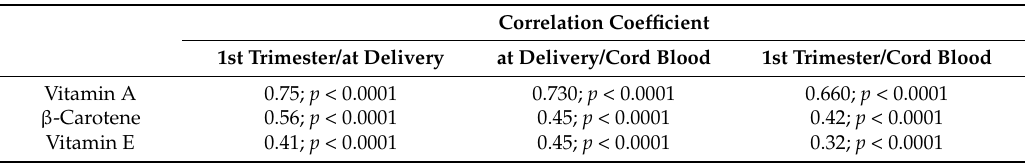
Table 4. Correlation between plasma vitamins A, E and β -carotene during the 1st trimester of pregnancy, at delivery and in cord blood